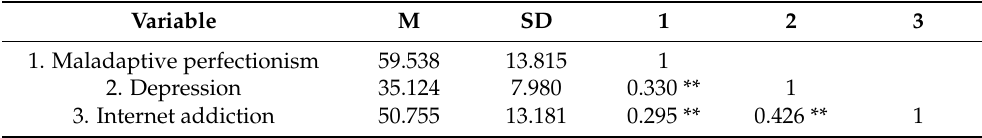
Table 2. Descriptive statistics and bivariate correlations of key variables.